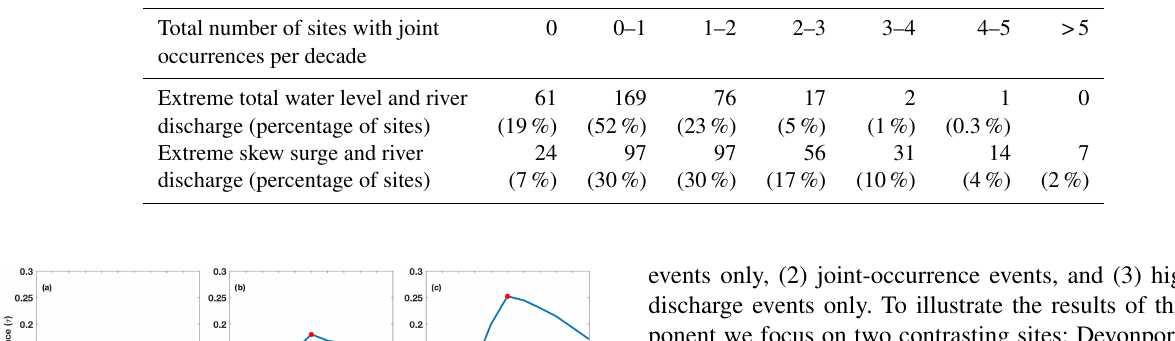
Table 3. The number of sites with joint occurrences per decade between (i) total water level and river discharge and (ii) skew surge and river discharge.